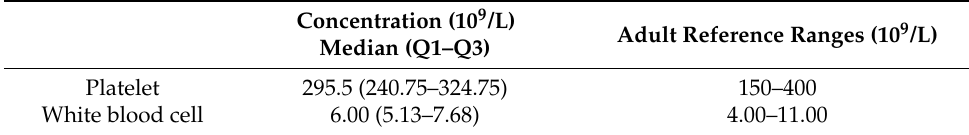
Table 1. Platelet and WBC counts in whole